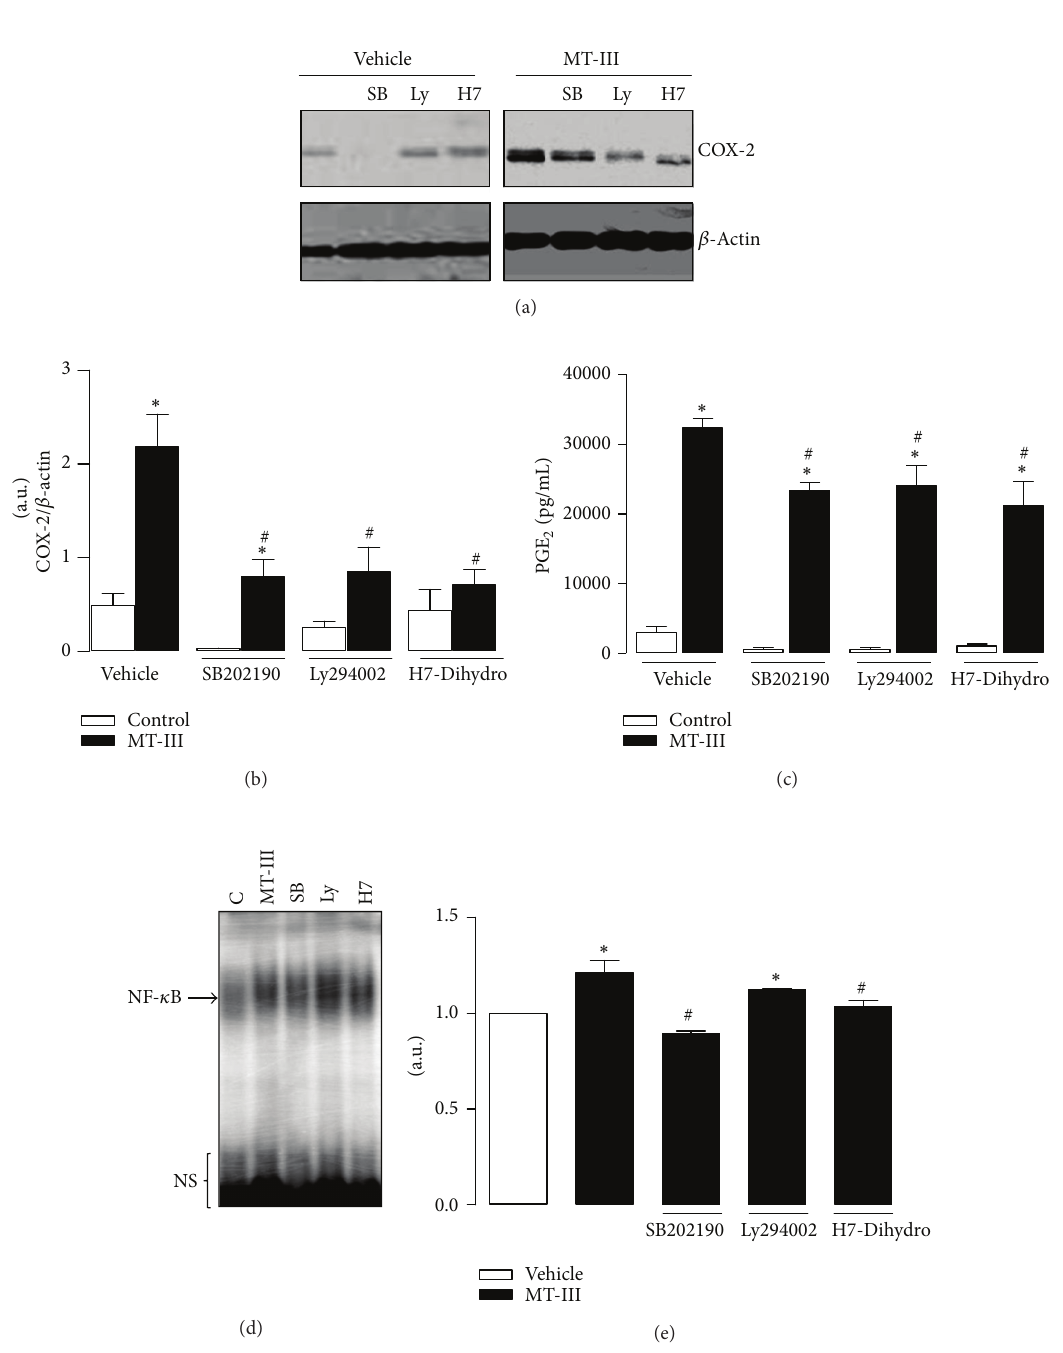
Figure 4: Effect of inhibition of p38MAPK, PI3K, and PKC on COX-2 expression, PGE 2 production, and NF- 𝜅 B activation induced by MT- III. Resident peritoneal macrophages ( 1 × 10 6 cells) were pretreated with either SB202190 (1 𝜇 M), Ly294002 (25 𝜇 M), or H7-dihydro (20 𝜇 M) and incubated during 4.5h with MT-III (0.4 𝜇 M). In electrophoretic mobility shift assay (EMSA), resident macrophages ( 3 × 10 6 cells) were pretreated with kinases inhibitors and incubated during 30 min with MT-III (a) Western blotting of COX-2 and 𝛽 -actin (loading control). (b) DensitometricanalysisofimmunoreactiveCOX-2bandintensities.(c)PGE 2 wasquantifiedinculturesupernatantsbyenzymeimmunoassays (see Section 2). (d) Nuclear extracts were prepared and assayed for 𝜅 B probe activity with 32 P-labeled double-stranded oligonucleotide 𝜅 B using EMSA. (f) Densitometric analysis of NF- 𝜅 B band intensities. Results are expressed as mean ± SEM from 3 experiments. ∗ 𝑃 < 0.05 as compared with control values. NS: nonspecific band; C: